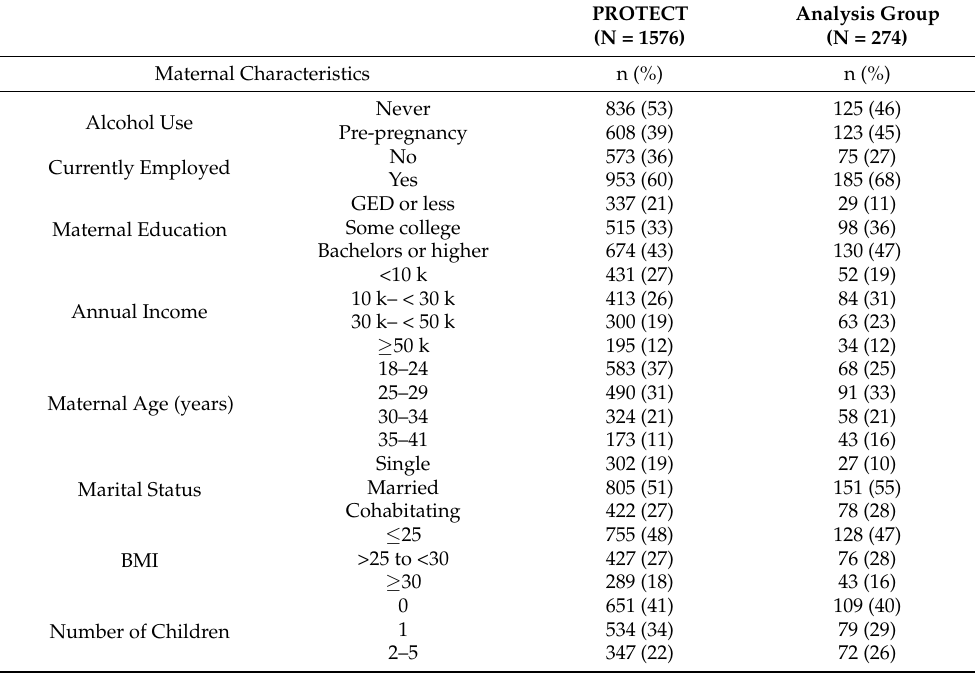
Table 1. Demographic characteristics of study participants from the Puerto Rico PROTECT cohort (N = 1576) and analysis group (N =